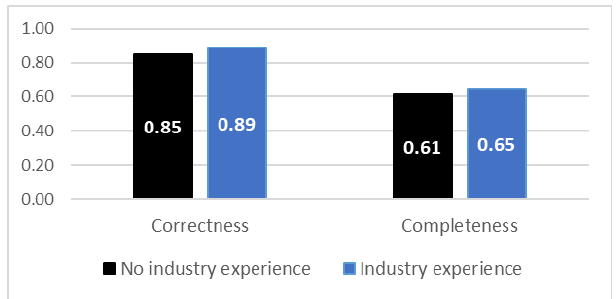
Fig. 7. Models correctness and completeness considering the industry experience.